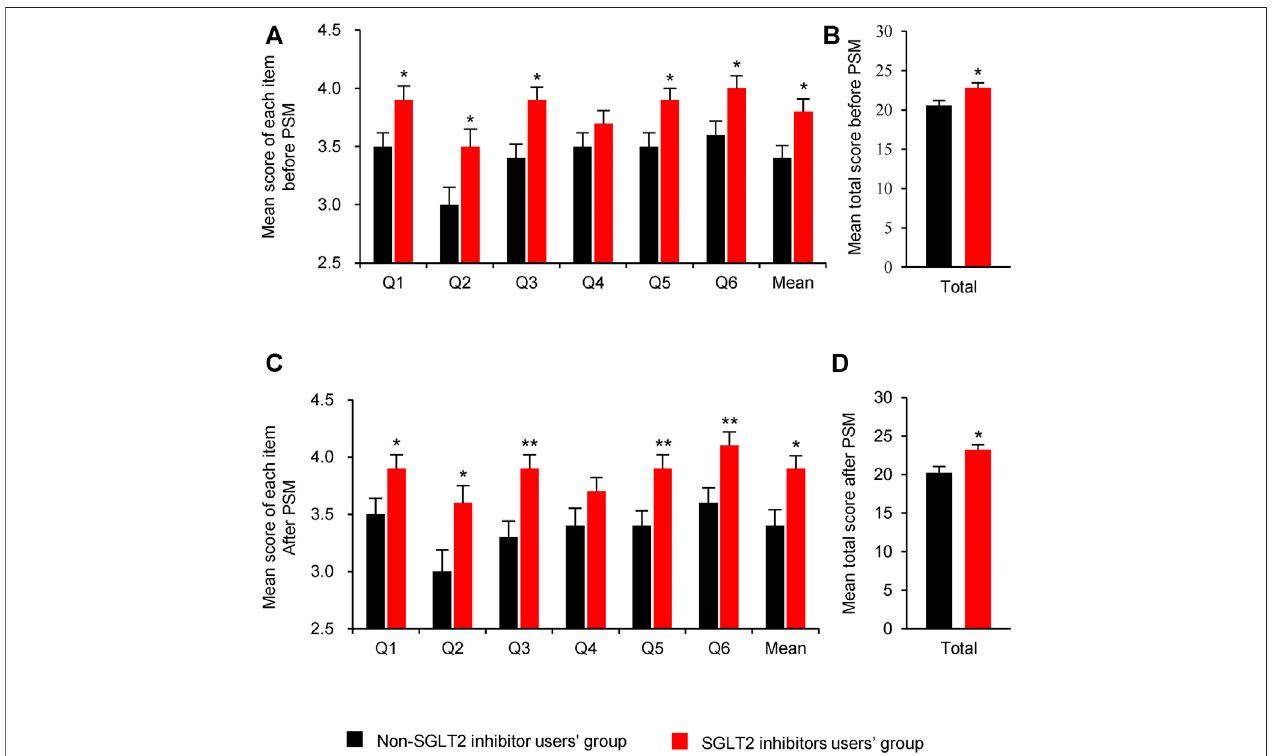
FIGURE 2 | Comparison of satisfaction scores between SGLT2 inhibitors users and non-SGLT2 inhibitors users. (A) : Mean score of each item before PSM; (B) : MeantotalscorebeforePSM; (C) :MeanscoreofeachitemafterPSM; (D) :MeantotalscoreafterPSM.Questions:Q1:abilitytocontrolbloodsugar;Q2:abilitytocontrol diabetic symptoms; Q3: how quickly medication-controlled blood sugar; Q4: medication ’ s effect on weight; Q5: tolerability of the medication; Q6: overall satisfaction. Abbreviations: PSM, Propensity score matching; SGLT2i: sodium-glucose co-transporter 2 inhibitors. Data were represented as Mean ± SE. * P < 0.05 and ** P < 0.01 vs. non-SGLT2 inhibitor users ’ group.